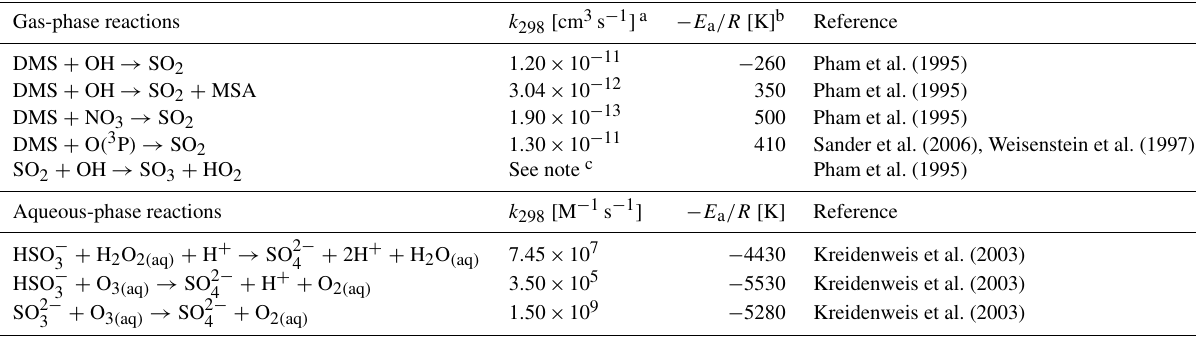
Table 1. Current StratTrop sulfate chemistry scheme. Gas-phase